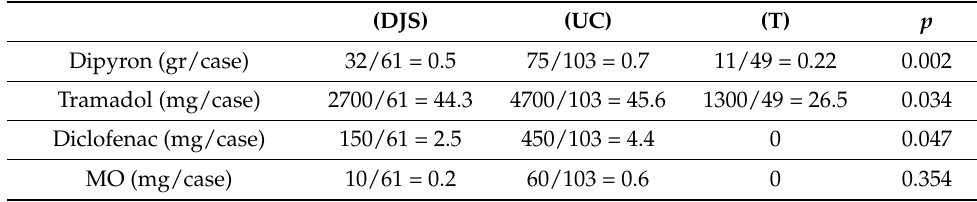
Table 3. Postoperative analgesic